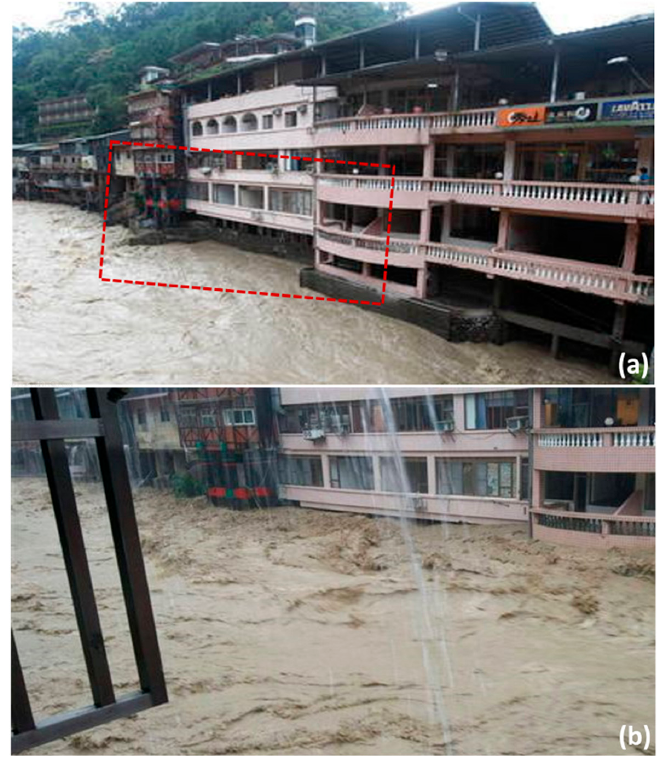
Figure 2. The initial stage ( a ) and the later stage ( b ) of the mountain flash flood along the Tonghou River induced by Typhoon Soudelor (2015) (Photo source: [15]).